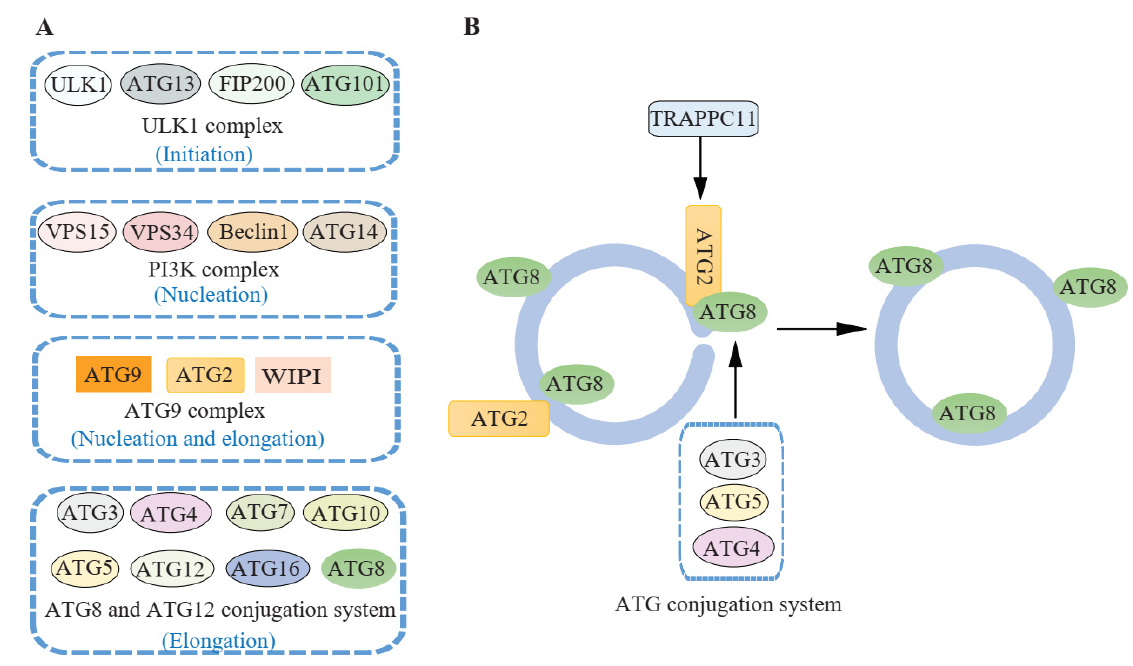
Figure 3. ATG proteins involved in autophagosome closure. ( A ) The ULK1 complex is required for the initiation of autophagy. The PI3K complex is responsible for PI3P production and essential for nucleation of the IM. The ATG9 complex consisting of transmembrane protein ATG9, lipid transfer protein ATG2 and PI3P-effector ATG18 (WIPIs) are required for both the nucleation and elongation steps. Two ubiquitin-like conjugation systems (ATG8 proteins conjugation to PE and the conjugation of ATG12–ATG5) play important roles in the elongation step. Mammalian ATG proteins including LC3 and the GABARAP subfamilies are shown as ATG8 for simplicity. ( B ) The ATG conjugation system including ATG3, ATG4, ATG5, ATG8 (GABARAPs) and the lipid transfer protein ATG2 are involved in autophagosome closure. In the ATG8 conjugation system, ATG3 acts as an E2-like enzyme. The ATG12–ATG5–ATG16 complex acts as an E3-like enzyme for the conjugation of ATG8 proteins (LC3 and GABARAP subfamilies) to PE. ATG4 cleaves ATG8 proteins to expose a glycine residue before conjugation, and cleaves ATG8–PE for the recycling of ATG8 proteins. The interaction between ATG2 and GABARAPs is also critical for the closure step. TRAPPC11, a TRAPP III-specific subunit, is required for the recruitment of ATG2 to isolation